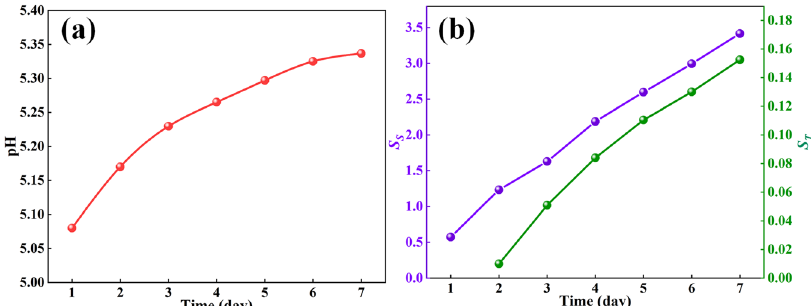
Fig. 9 The calculation results of pH and supersaturation. a Time dependence of the solution pH. b Time dependence of the supersaturation inside of the droplet.